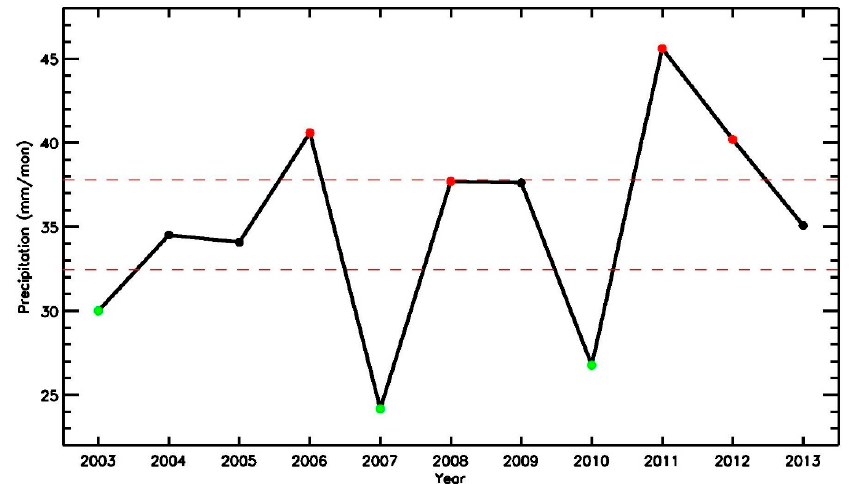
Figure 1. TRMM precipitation (black solid line) averaged over southwestern USA (32 ° N–42 ° N, 235 ° E–249 ° E) from June to September in 2003–2013. Red dashed lines represent mean precipitation ±0.5 times standard deviation of precipitation. Units for precipitation are mm/month. Red dots, green dots, and black dots indicate wet years, dry years, and normal years, respectively.